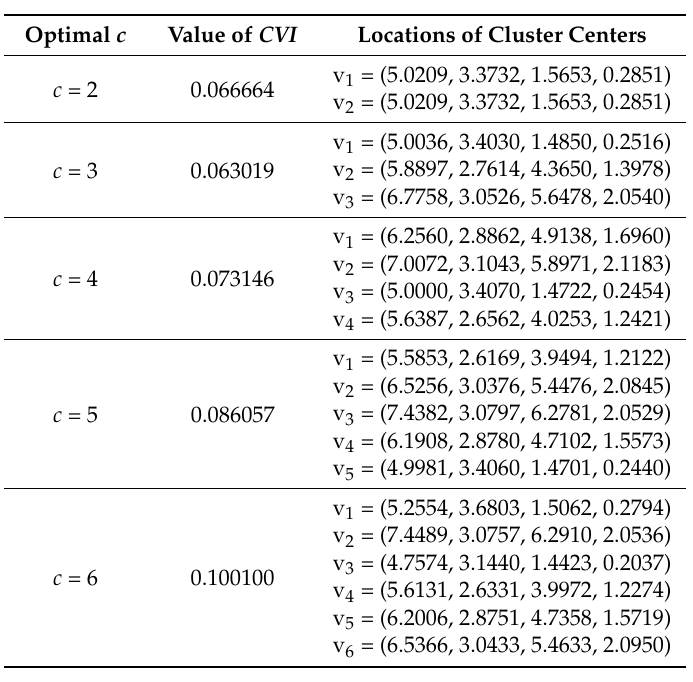
Figure 2. Optimization results of 20 experiments of Iris data sets. Table 1. Optimal cluster numbers and the corresponding CVI optimized by